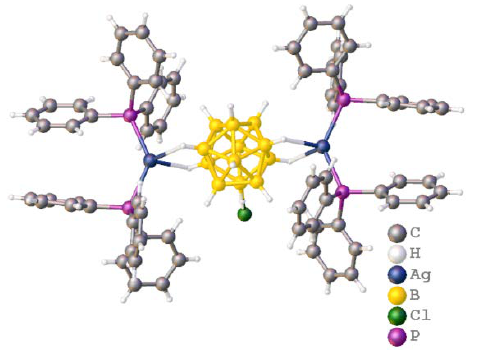
Figure 3. Structure of binuclear silver(I) complex [Ag 2 (Ph 3 P) 4 [B 12 H 11 Cl]].